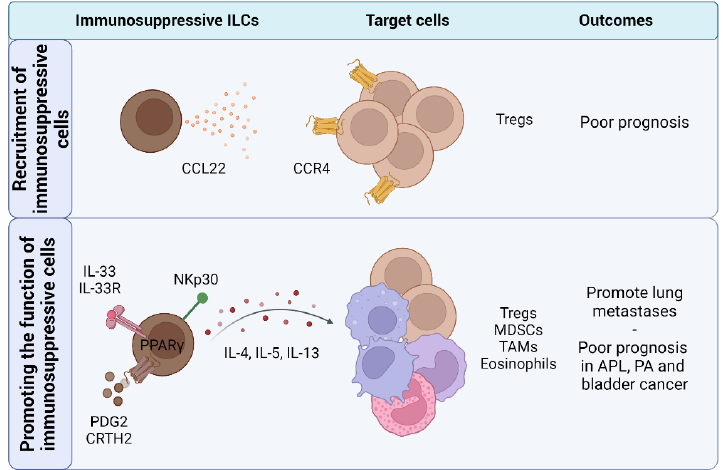
Figure 4. ILCs recruit and promote immunosuppressive cells in cancer . ILCs have been shown to recruit Tregs into tumours through secretion of CCL22. Furthermore, ILCs promote expansion and suppressive functions of Tregs, MDSCs, TAMs, and eosinophils through the expression of